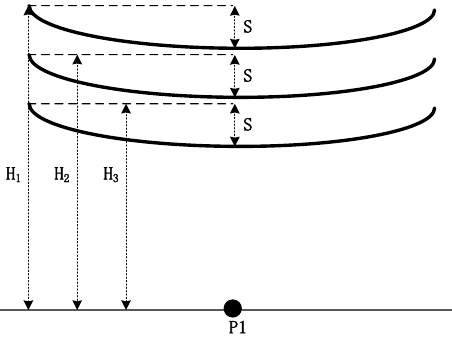
Figure 11. Tower configurations of different heights. the electric field is shown in Figure 12.